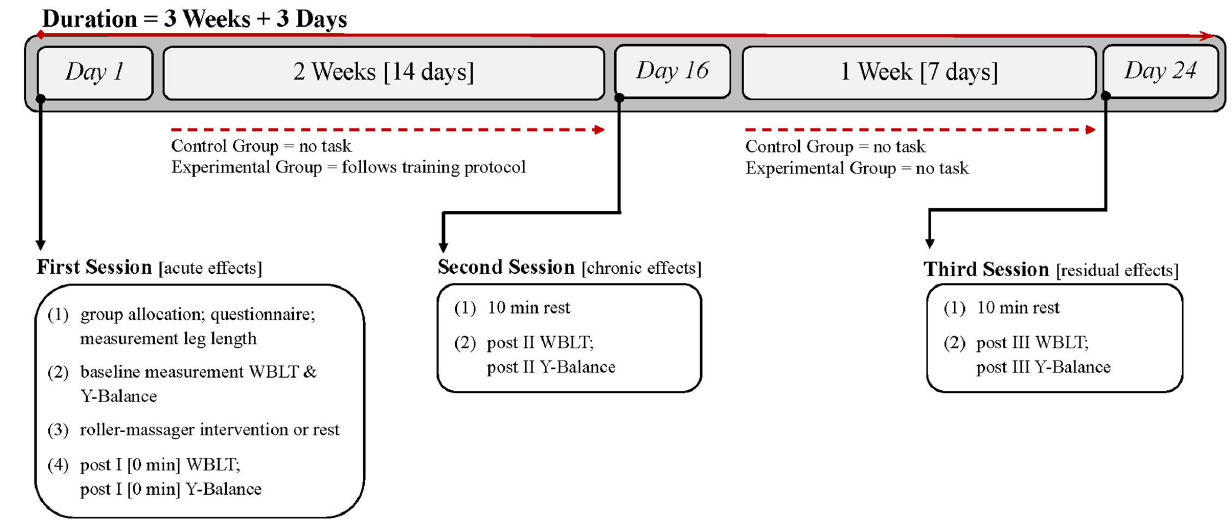
( = passive control group) or 1 ( = experimental